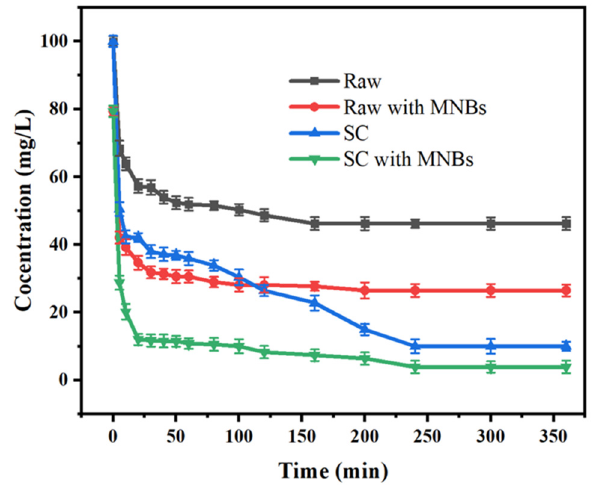
Figure 4. Influence of adsorption time on concentration and adsorption capacity with and without bubbles.